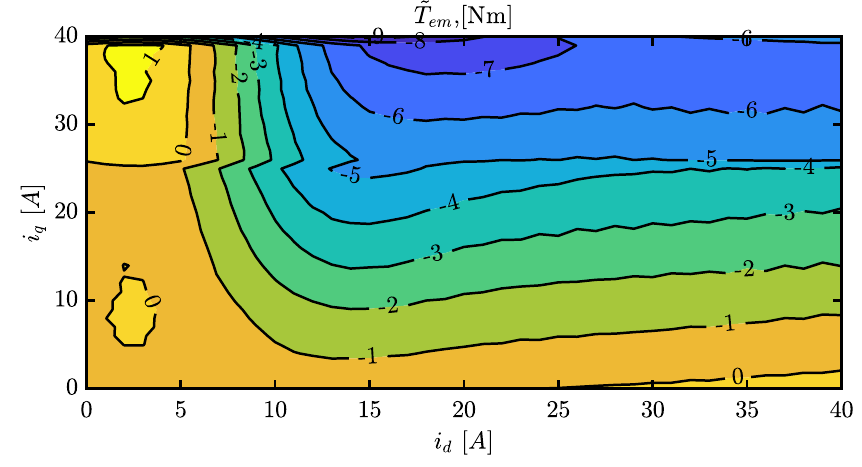
Figure 10. Discrepancy of the torque